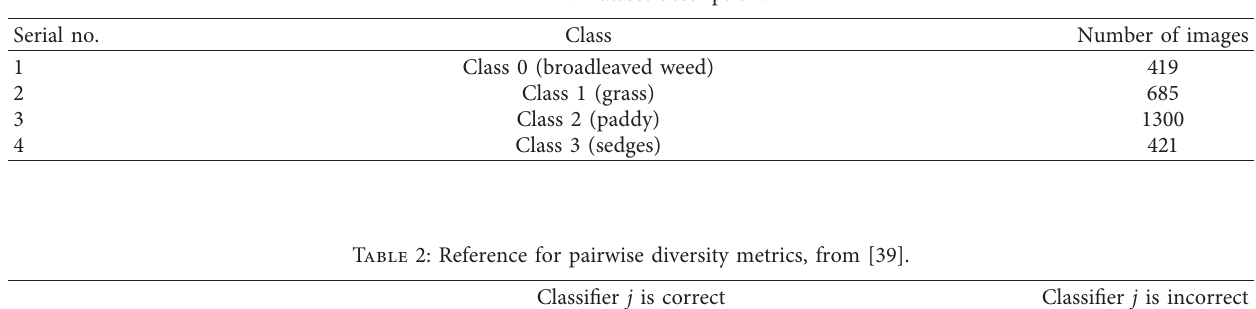
Table 1: Dataset description.